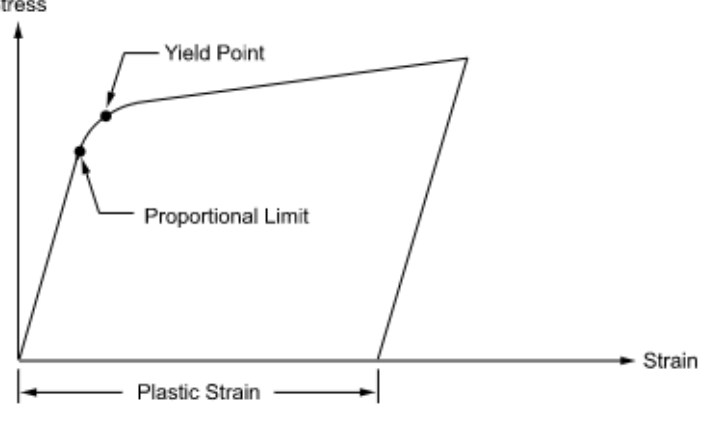
Fig. 15. Elasto-plastic (stress-strain)